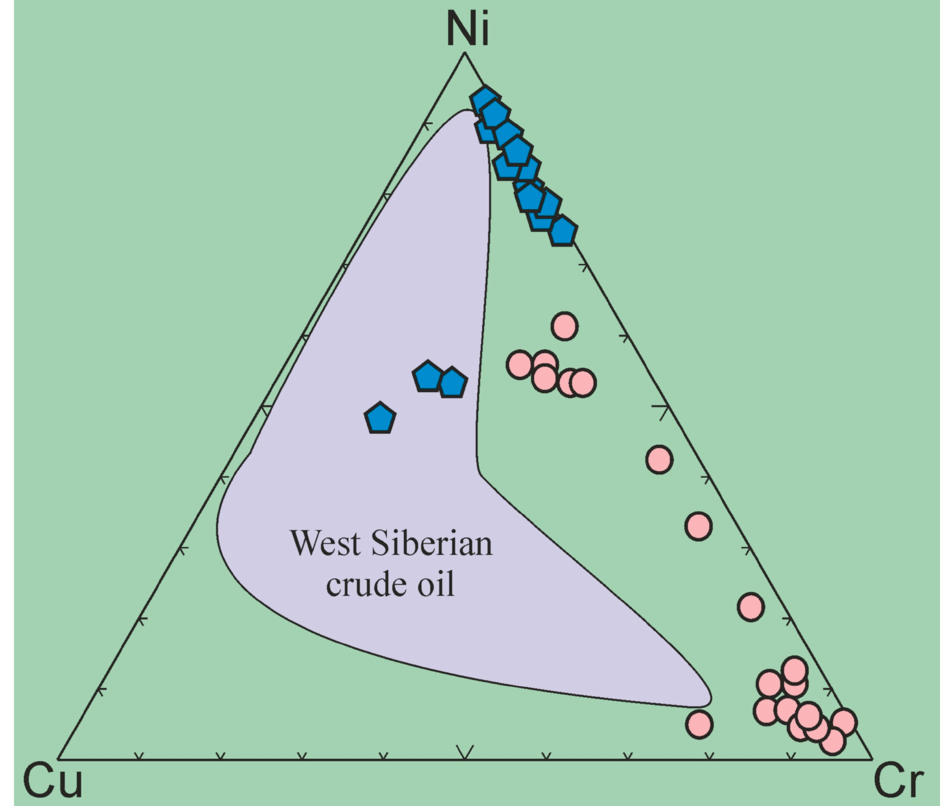
Figure 2. Taxonomy of crude oil fields by the content of nickel, copper, and chromium in crude oils. Note: the field shows the West Siberian province [6]. Our data: the circles—crude oils of the West-Siberian Urals part,